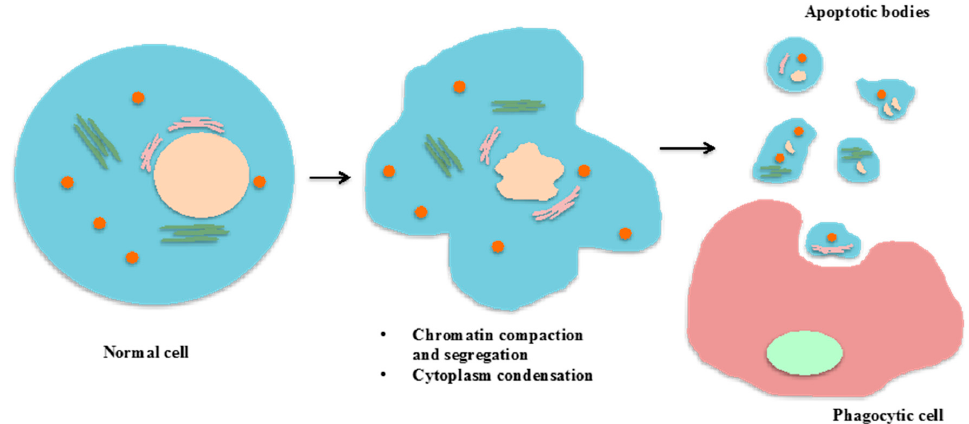
Figure 2. Formation of apoptotic bodies and clearance by phagocytosis. Formation of